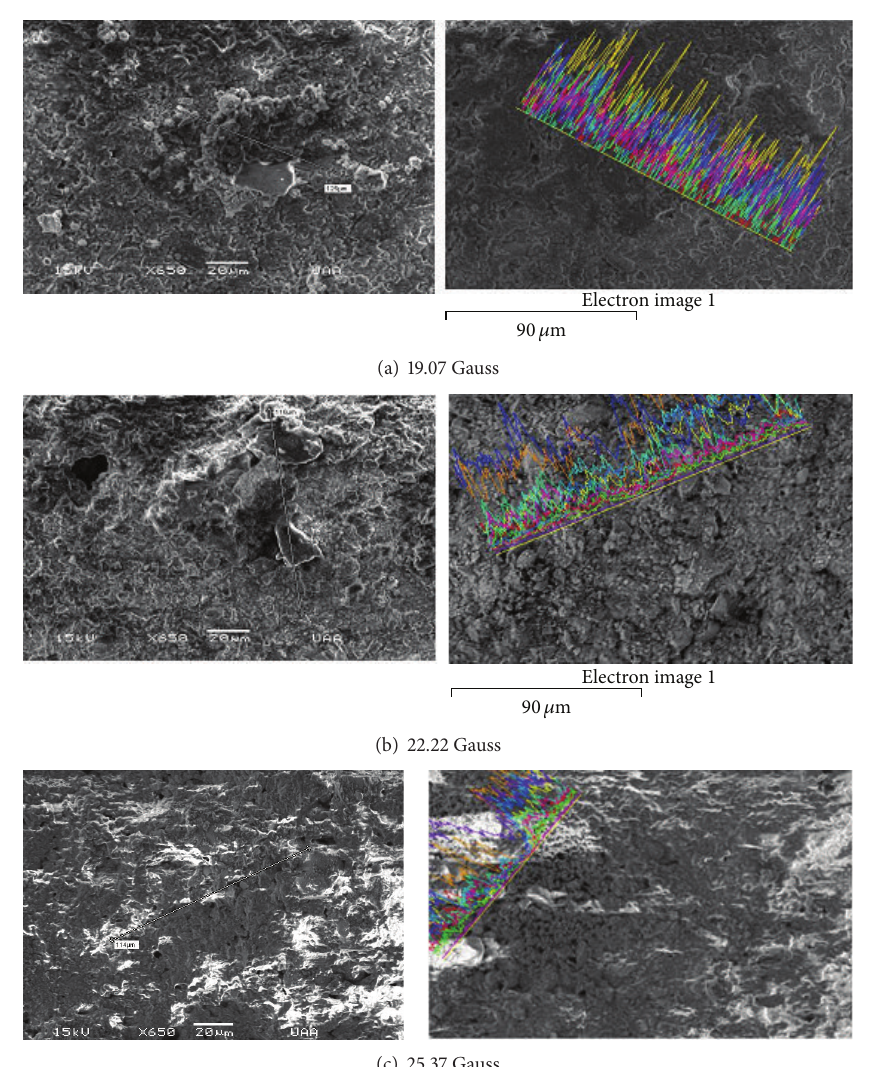
Figure 8: Appearance of cement paste samples with different magnetic field